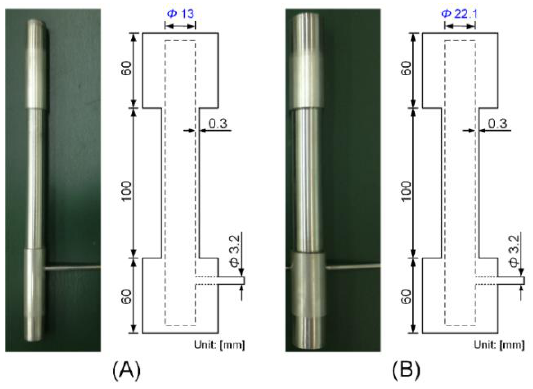
Figure 2. Photographs and dimensions of two tube specimens: ( A ) Tube1-03 and ( B ) Tube3-03. Table 1. Chemical composition of SS-304 (mass fraction,